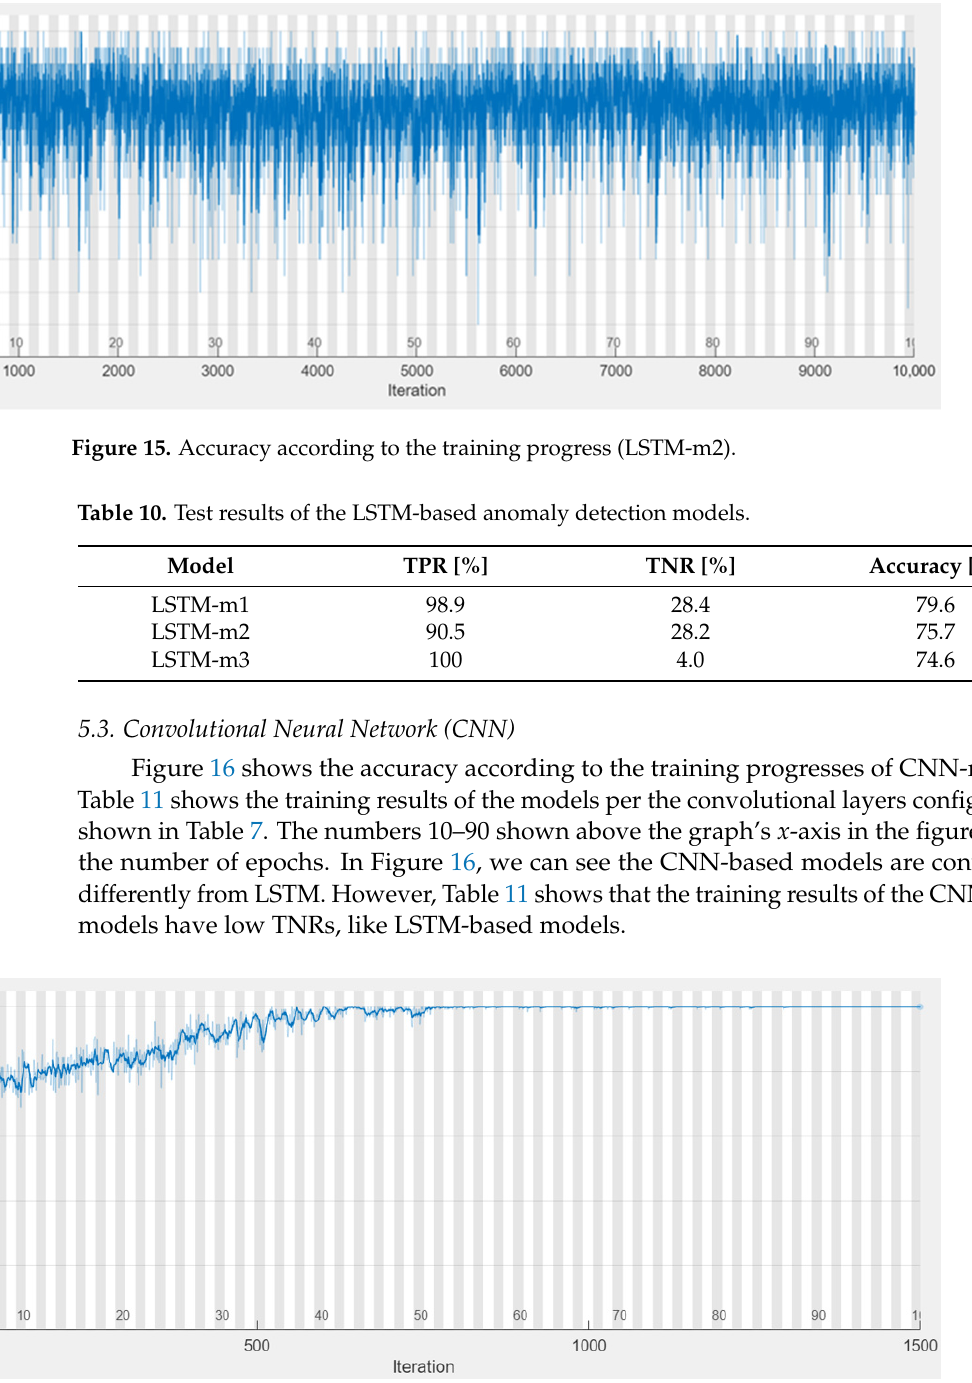
15 of 21 Table 9. Test results of MLP-based anomaly detection models. Model